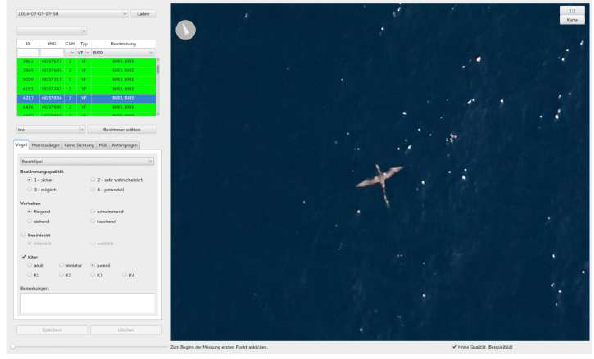
Figure 4: Screen shot of a software interface used for species